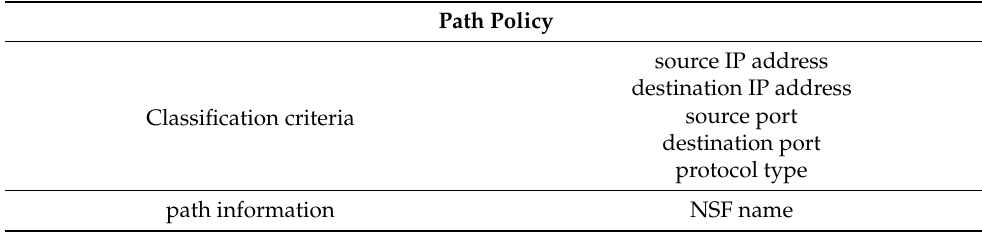
Figure 6. Advanced Path Policy Information Model. Table 1. Advanced Path Policy Data